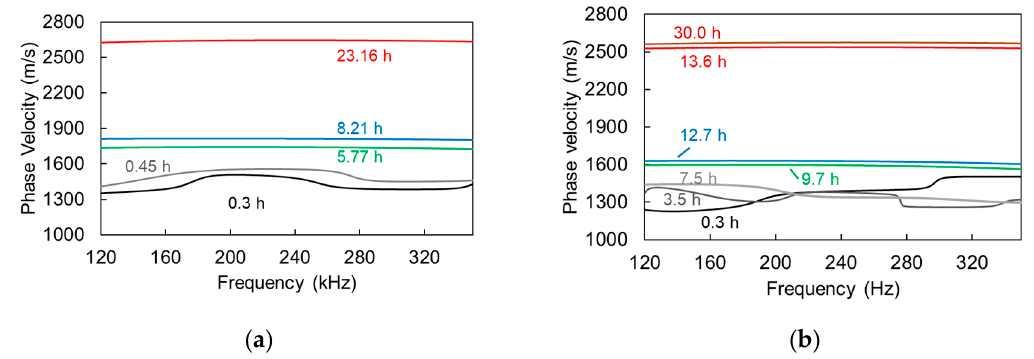
Figure 8. Phase velocity vs. frequency curves for fresh ( a ) cement mortar and ( b ) cement mortar with SAPs.